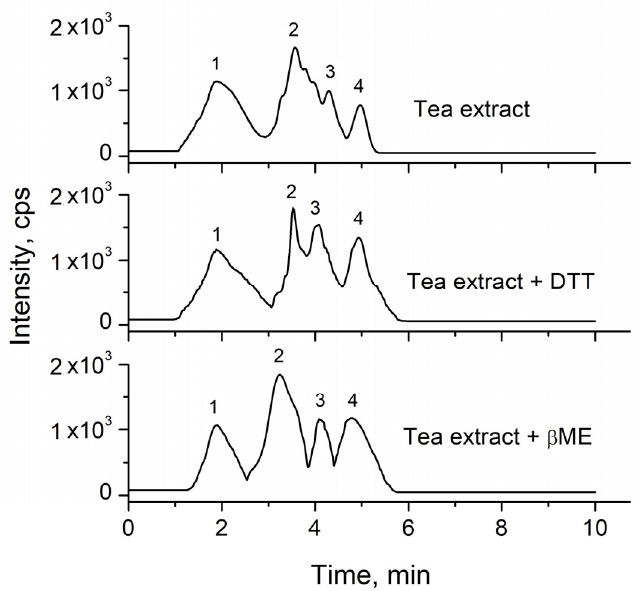
Figure 2. Chromatograms of water extract of green tea (sample Lung-Ching-3) without and with the addition of DTT and β ME. Each addition was made 5 min after the addition of water to the tea sample. Atlantis HILIC column, eluent: methanol and water, pH 5.8 (85/15, v / v ). 1: MeSeCys; 2: SeMet; 3: SeMetO; 4: SeCys.